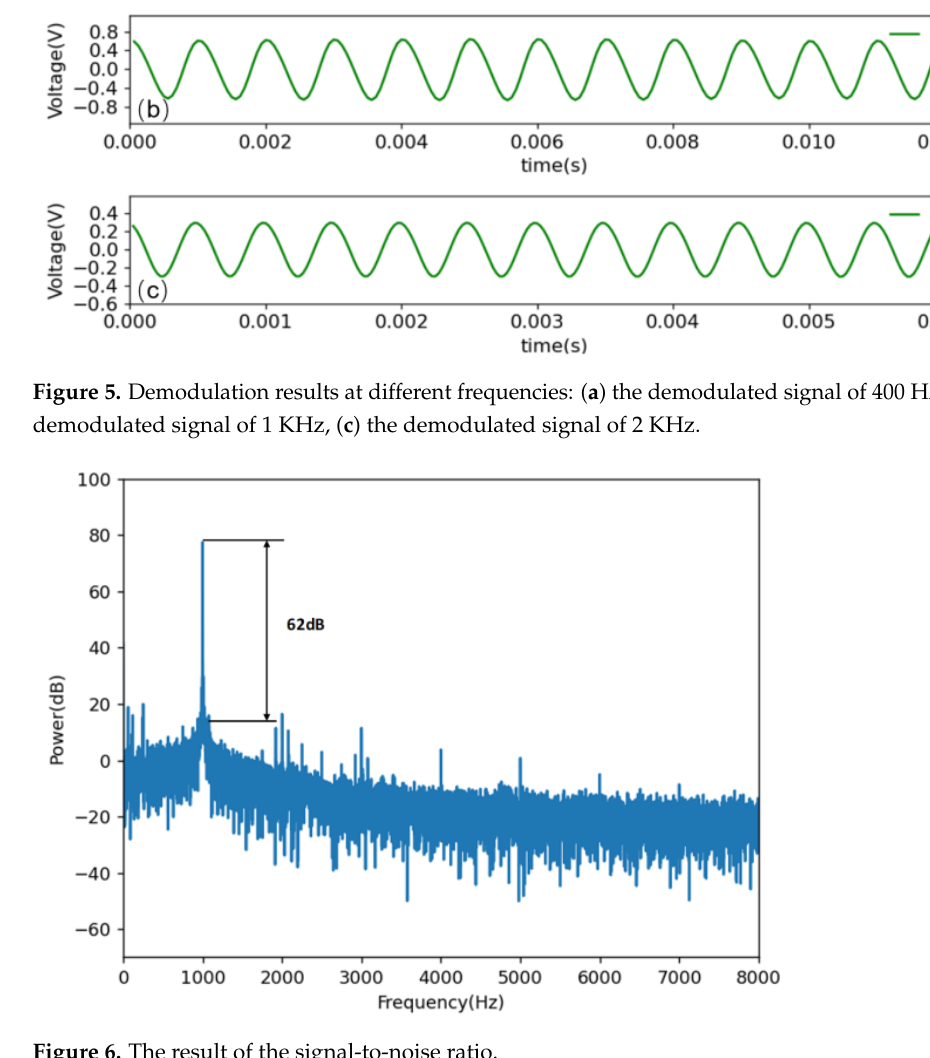
Figure 6. The result of the signal-to-noise ratio.